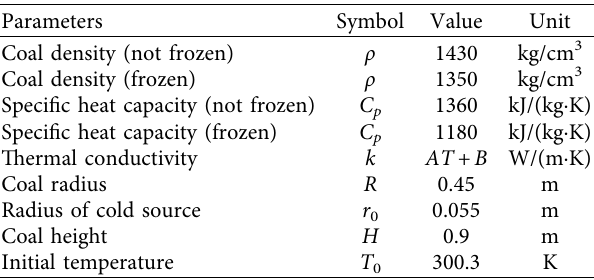
Figure 4: Calculation model and dissecting grid. Table 2: Model parameters.